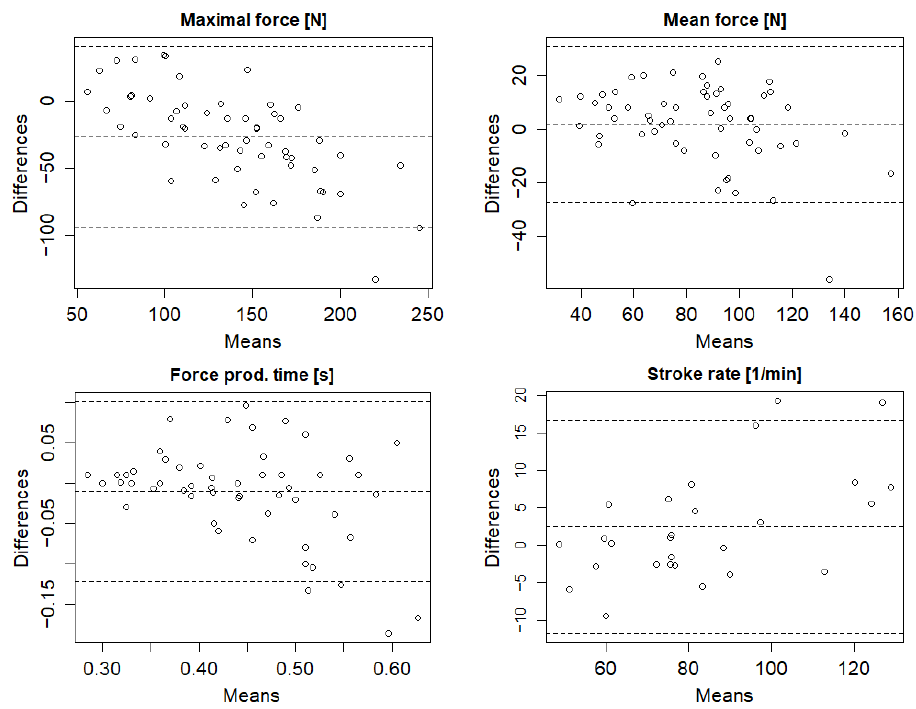
Figure 3. Bland–Altman analysis between SmartPaddle and strain-gauge shaft in key paddle stroke variables ( n = 6).